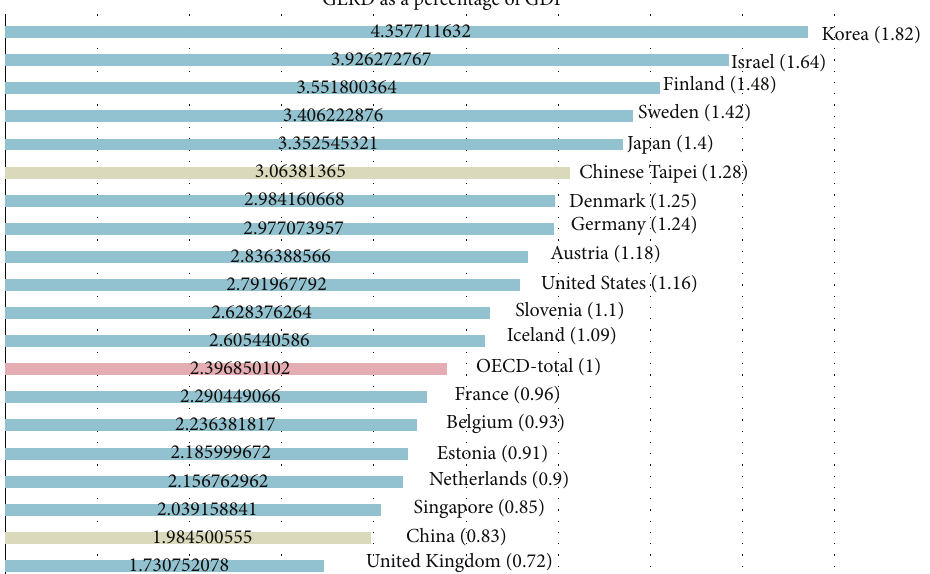
Figure 2: The proportion of GERD against GDP.